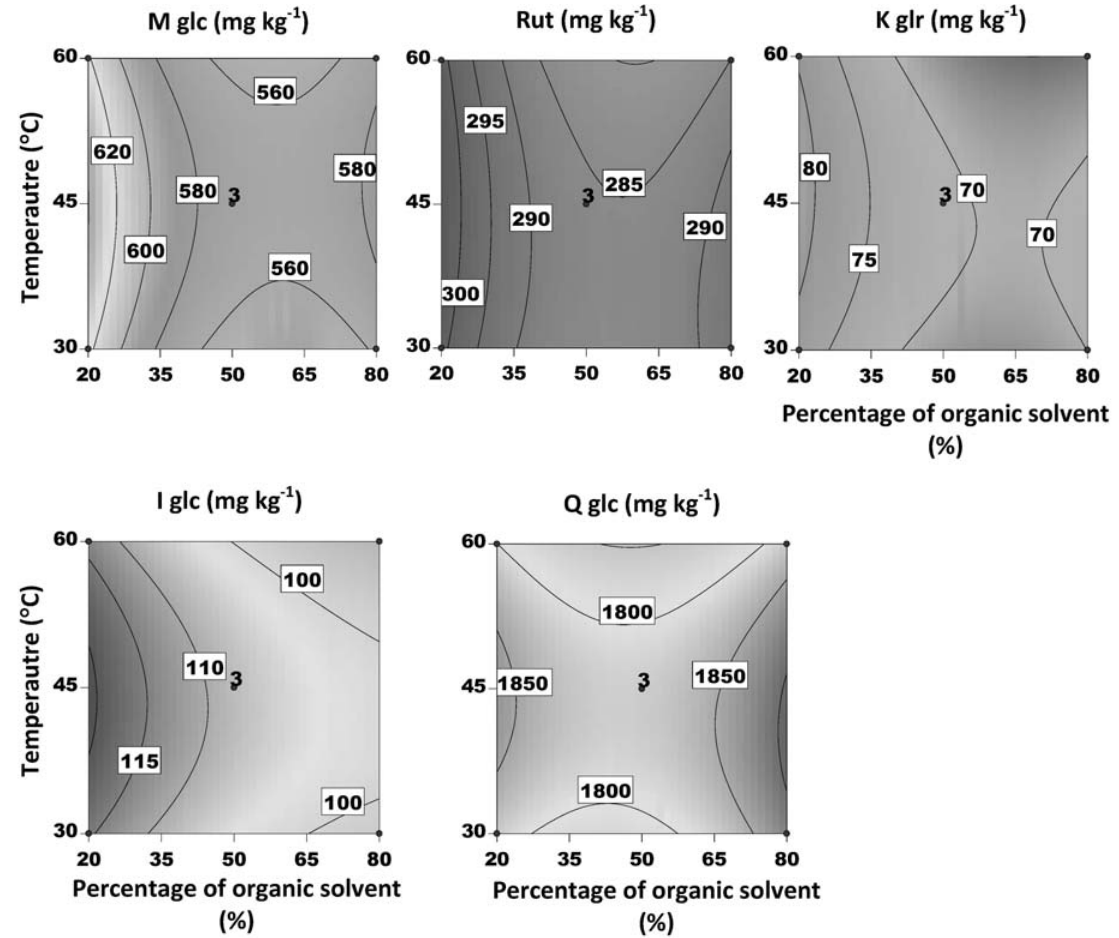
Fig. 5. Contour plots of most prominent interaction factors for individual flavonols from grape skins using acetonitrile as organic modifier. I glc – Isorhamnetin-3- O -glucoside; K glr – Kaempferol-3- O -glucuronide; My glc – Myricetin-3- O -glucoside; Q glc – Quercetin-3- O -glucoside; Rut –